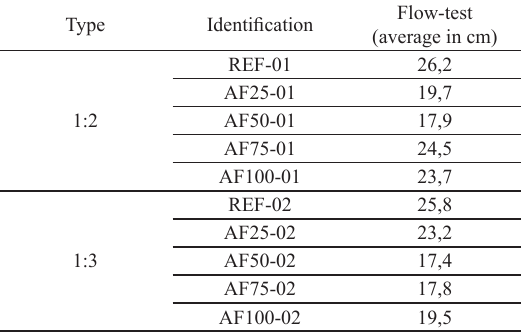
Table 5. Dosages and their respective consistency.